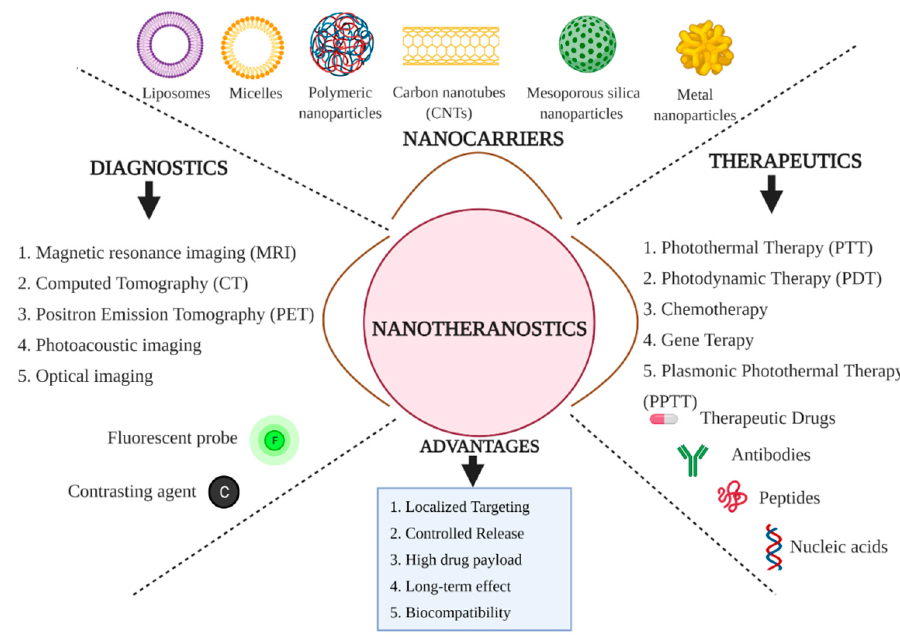
Figure 1. Schematic overview of the concept of nanotheranostics which infers the use of engineered nanomaterials for both diagnostics and therapeutic modules through a single platform.